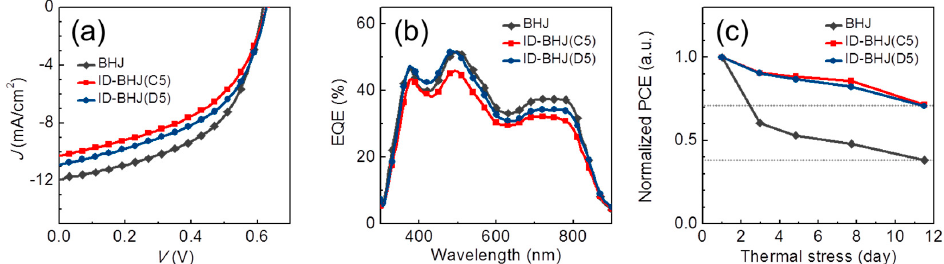
Figure 7. The device performances of BHJ, ID-BHJ(C5) and ID-BHJ(D5) compared in ( a ) a current density–voltage ( J–V ) curve; ( b ) external quantum efficiency (EQE) spectra; and ( c ) long-term thermal stability (compared on a hotplate at 80 °C for more than 10 days).